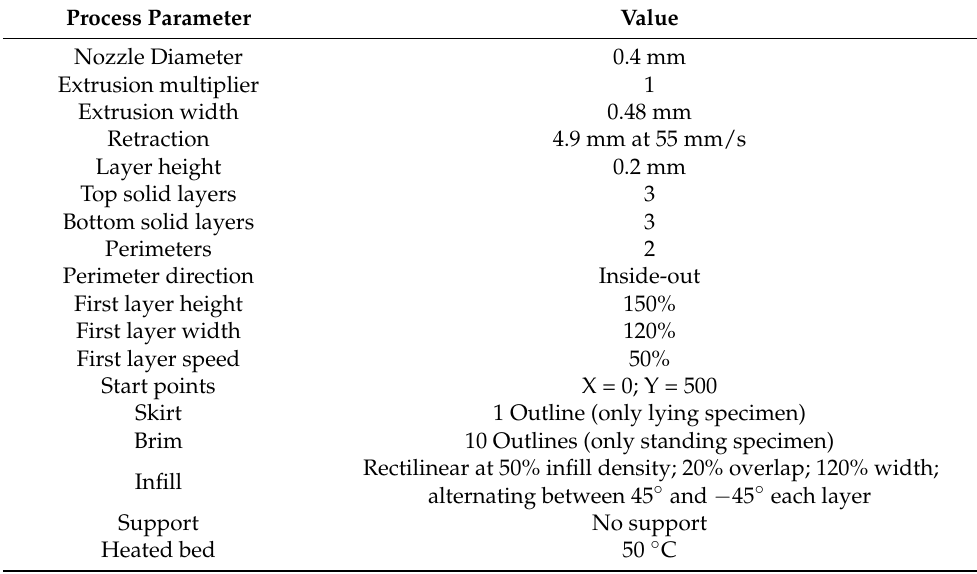
Table 2. Process parameters that have not been varied during the